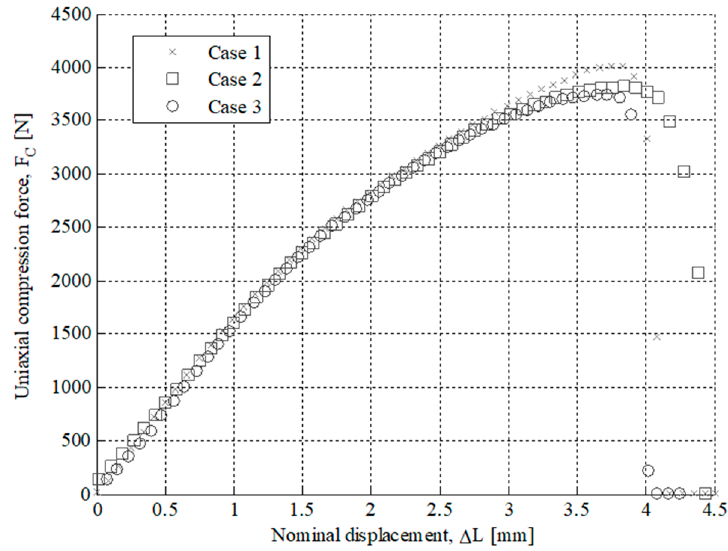
Figure 12. Uniaxial compression load facing nominal displacements for the Z axis printed part tested.